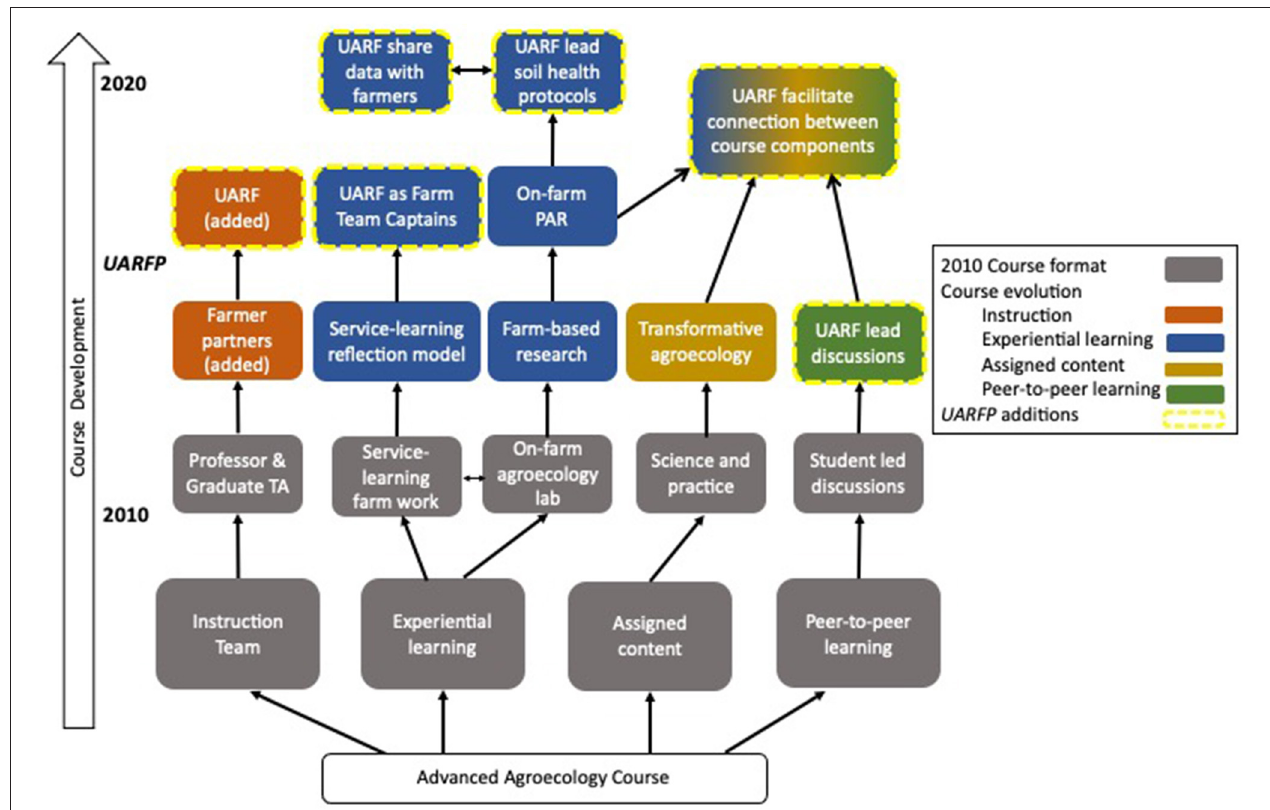
FIGURE 1 | Diagram depicting the evolution of the PSS 212: Advanced Agroecology Course, showing its four core components (instruction team, experiential learning, assigned content, and peer-to-peer learning), over a decade of course development (2010–2020). Arrows reflect the direction of course development toward more participatory and transdisciplinary methods and highlight the role of the Undergraduate Agroecology Research Fellows Program (UARFP) in accomplishing increasingly transformative